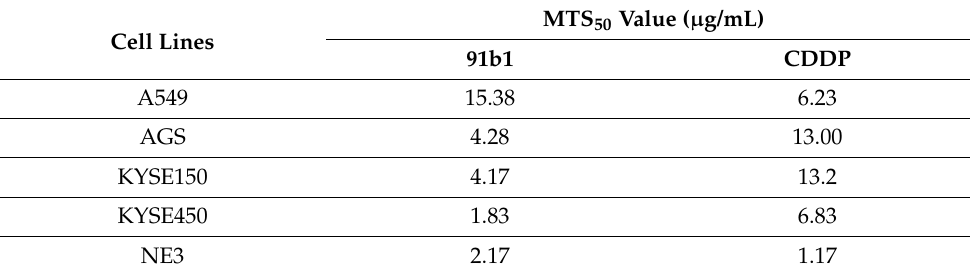
CDDP: cisplatin. N = 4. Vehicle control: 0.1% DMSO (dimethyl